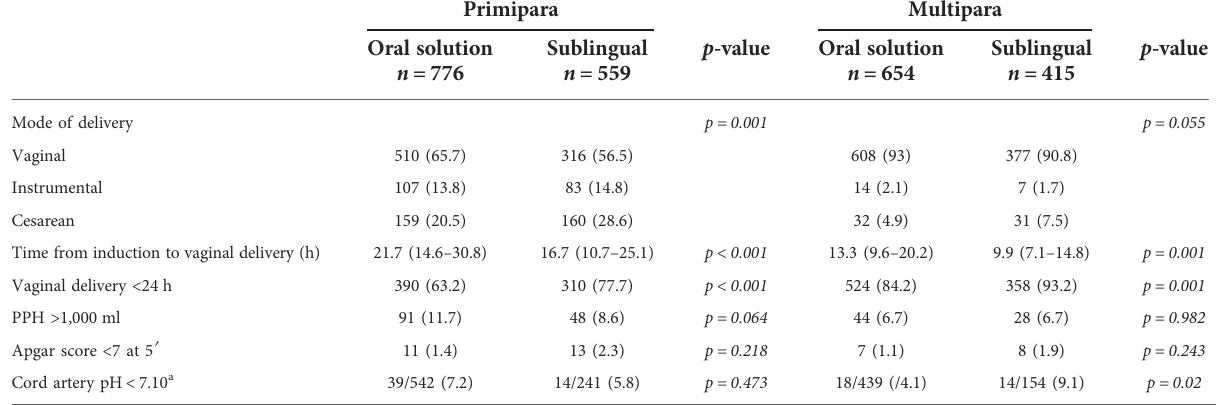
TABLE 2 Primary and secondary